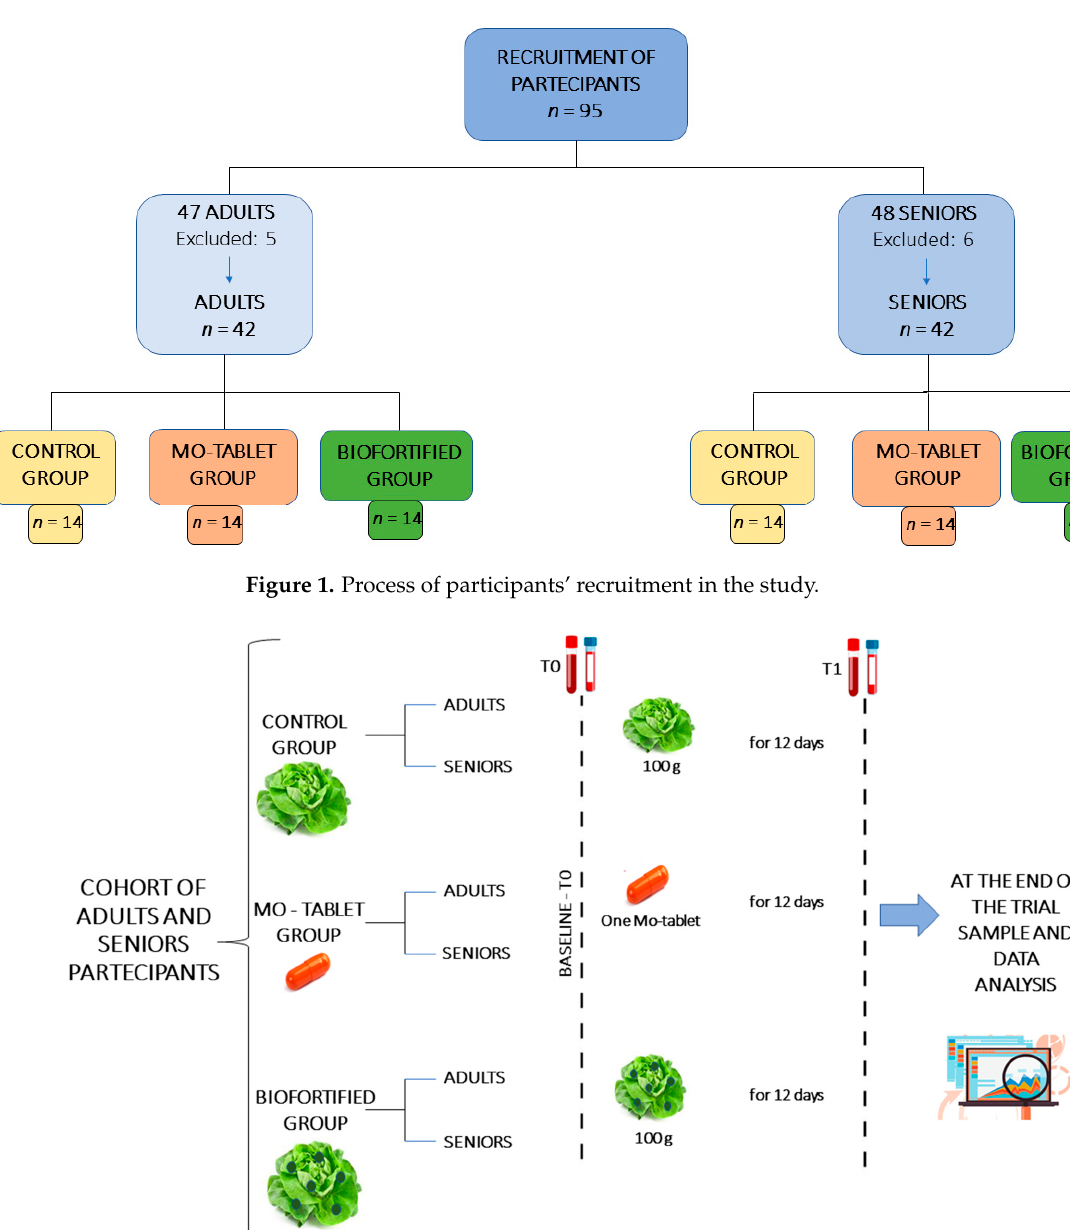
Figure 2. Overview of the experimental design. Samples of blood were taken at baseline and after 12 days. The control group consumed 100 g of lettuce containing 0.21 mg of sodium molybdate, and the intervention group consumed 100 g of Mo-biofortified lettuce containing 8 mg of sodium mo- lybdate every day for a total of 12 days. The Mo-tablet group was supplied with one tablet of Mo containing 150 μ g of sodium molybdate every day for a total of 12 days. Biofortification of lettuce with molybdenum was used, with a dose of 3 μ mol Mo L − 1 supplied in foliar spray as sodium mo- lybdate (Na 2 MoO 4 ) during the period of growth [17] .